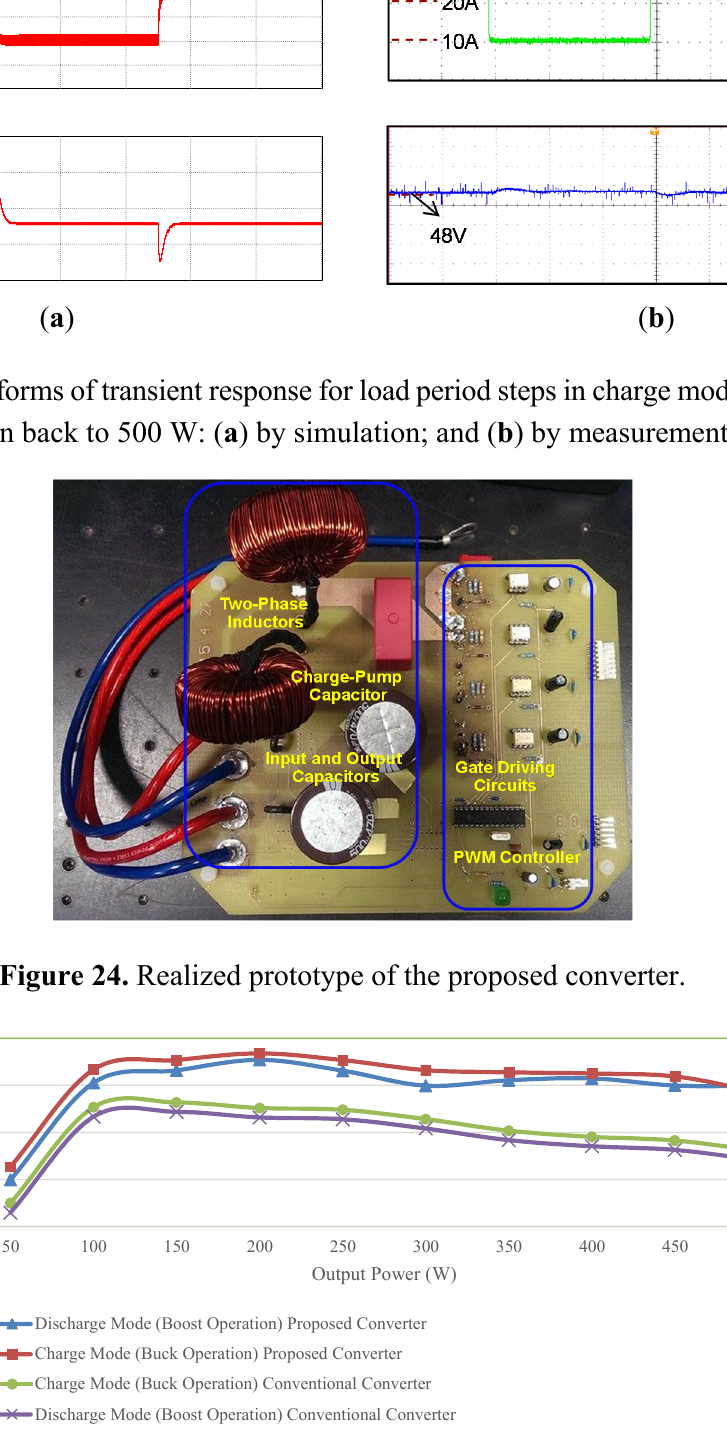
Figure 25. Measured efficiency in the proposed converter and conventional bidirectional buck/boost